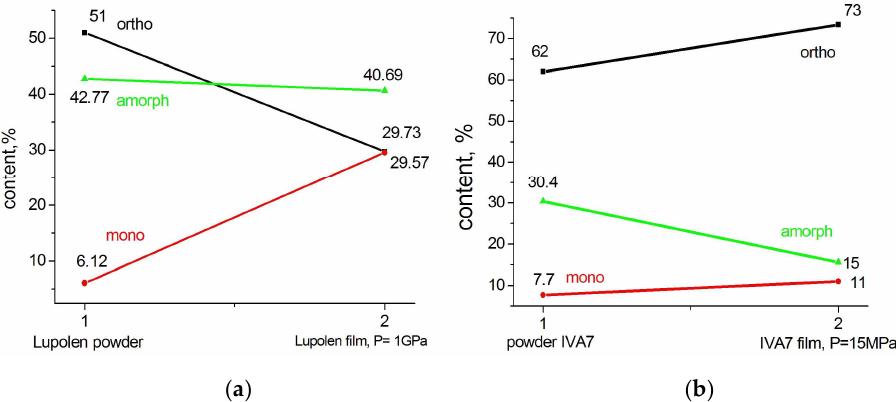
Figure 10. Change in phase composition of Lupolen ( a ) and IVA7 ( b ) reactor powders (1) after cold compression (2).